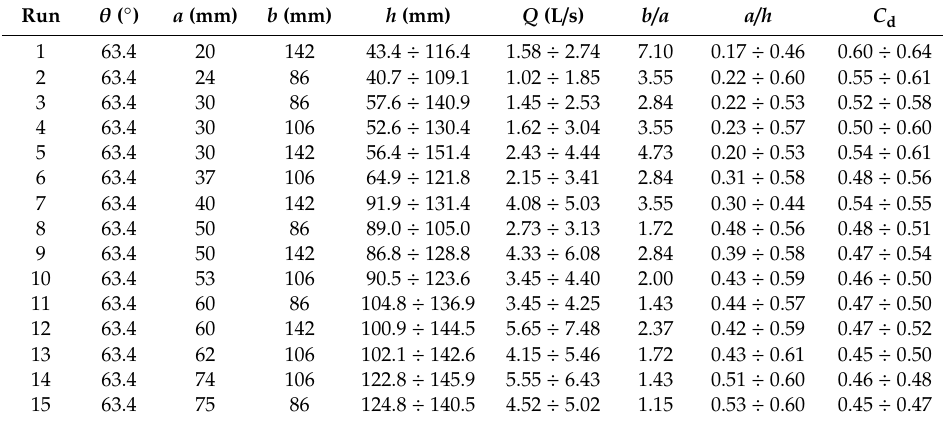
Figure 2. ( a ) Physical model (view from downstream) and ( b ) definition sketch, with notation. Table 1. Experimental data Series 1.